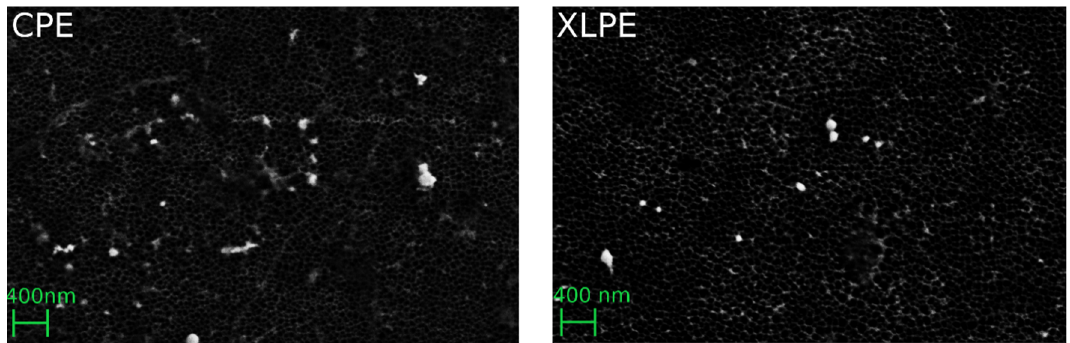
Figure 2. Filter images of the analyzed backside PE wear particles.